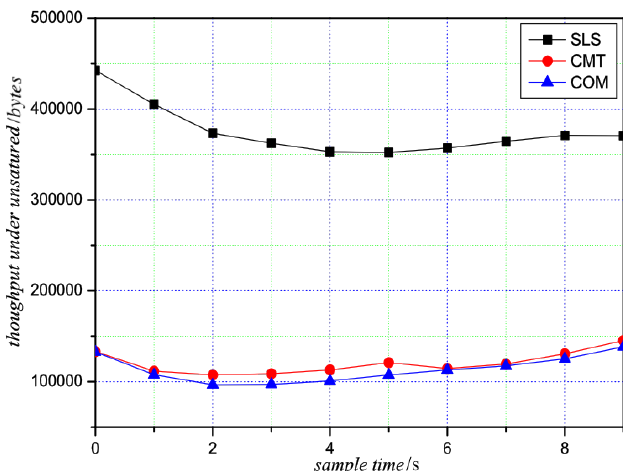
Figure 9. Throughput of the proposed method and other methods under unsaturation.